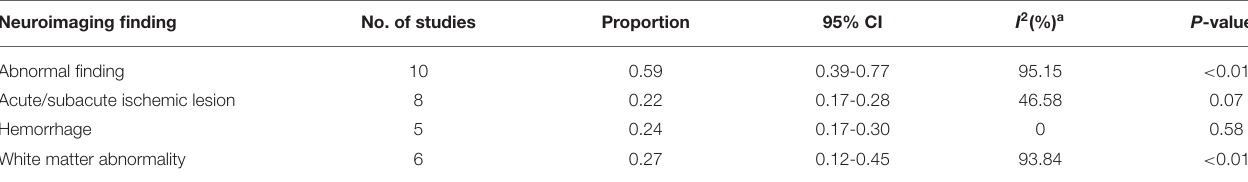
TABLE 2 | Summary of quantitative analysis